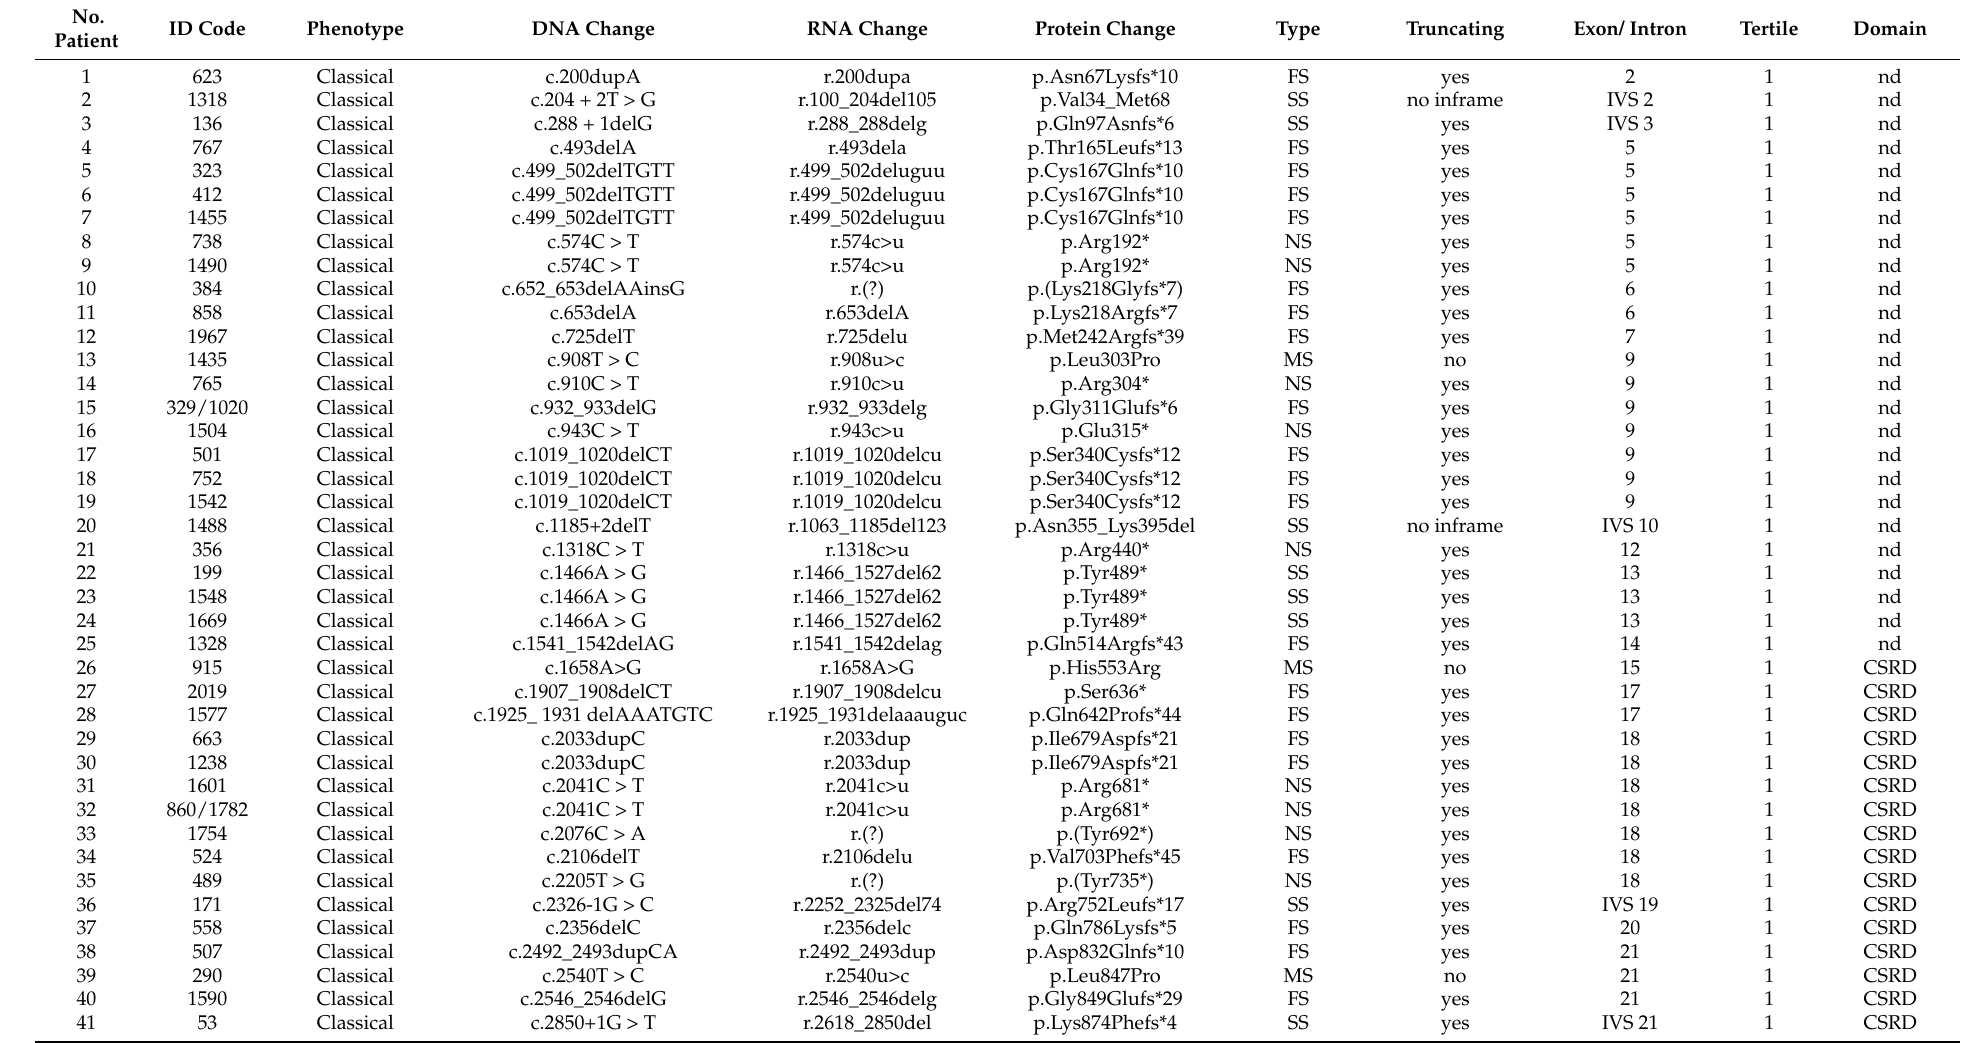
Table 5. NF1 variants observed in 106 classical NF